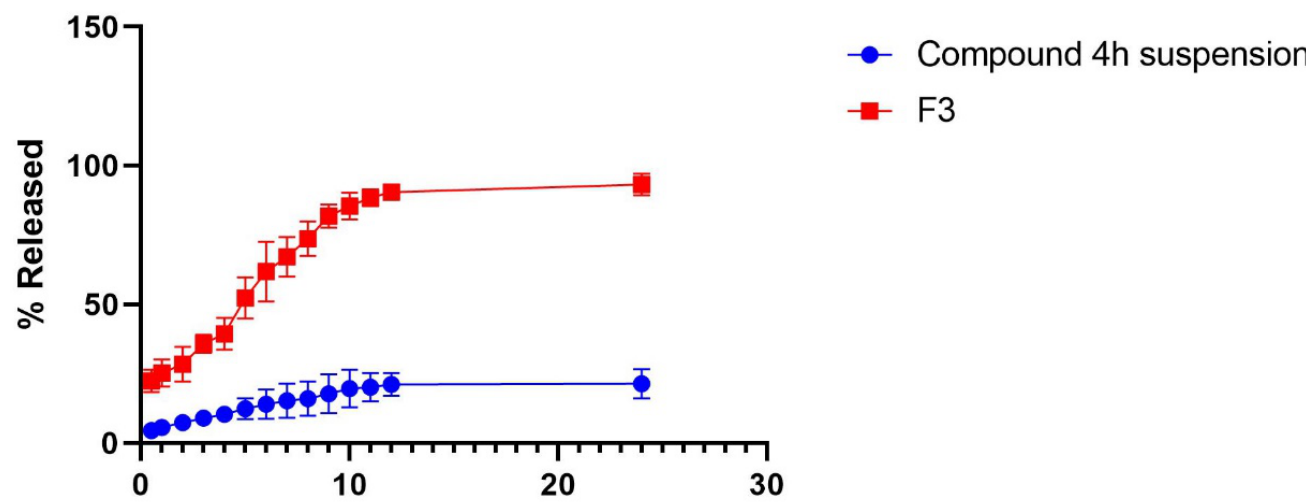
Figure 16. % of compound 4h released ± S.D. from the optimized NLC (F3) compared to that of 4h suspensions.